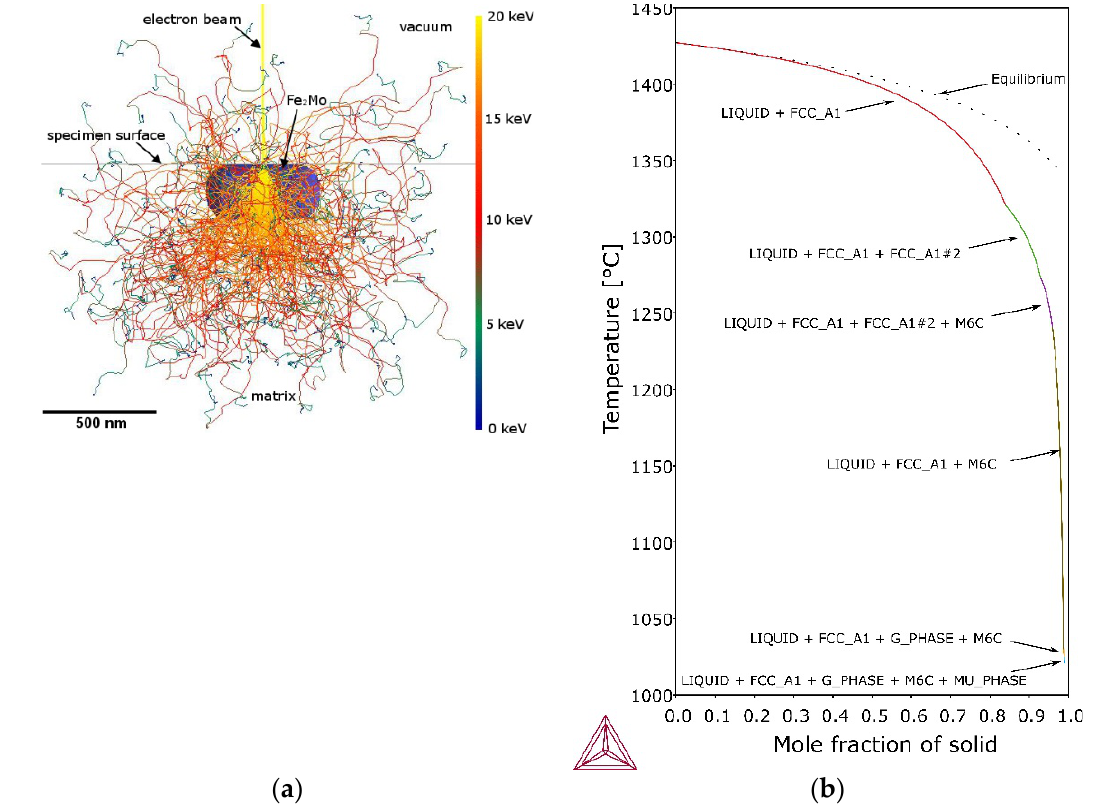
Figure 6. Monte Carlo simulation of electron trajectory in Fe2Mo precipitate and Fe-0.0768C-0.921Si-0.168Mn-4.38Mo-16.9Ni-11.7Co-0.332Ti model alloy matrix ( a ) and Scheil solidification simulation of Fe-0.0768C-0.921Si-0.168Mn-4.38Mo-16.9Ni-11.7Co-0.332Ti model alloy matrix ( b ).